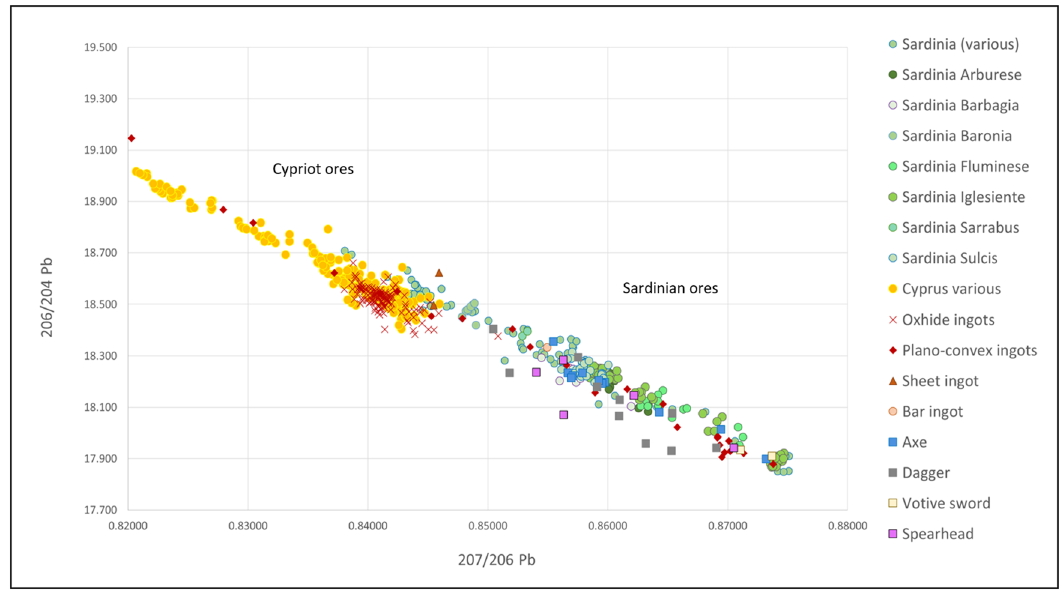
Figure 4: LIA carried out on Sardinia between the 1990s and early 2000s. The plot summarizes the provenance of the ingots and artefacts. The majority of the metalworks overlap with Sardinian ores, especially the ores in the Iglesiente and Sulcis districts. Data source: OXALID database ( Plot: Valentina Matta © )